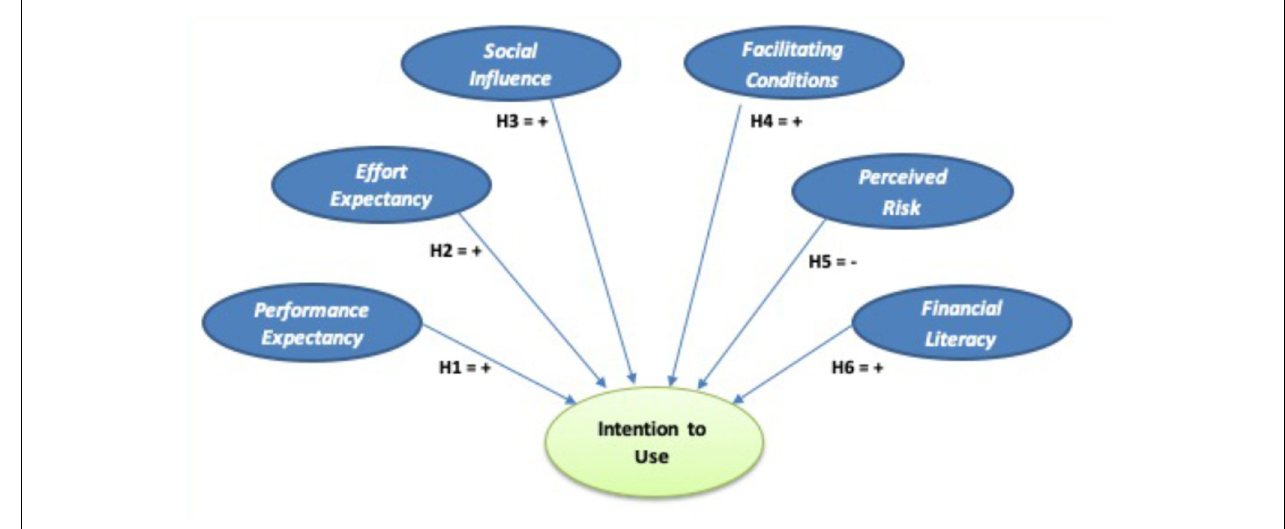
FIGURE 1 | Proposed theoretical model for the intention to use